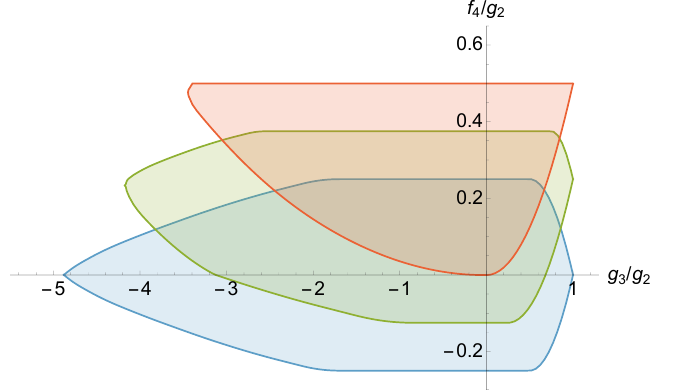
Figure 5 . Bounds in the plane g 2 red regions corresponds to f interpolation.